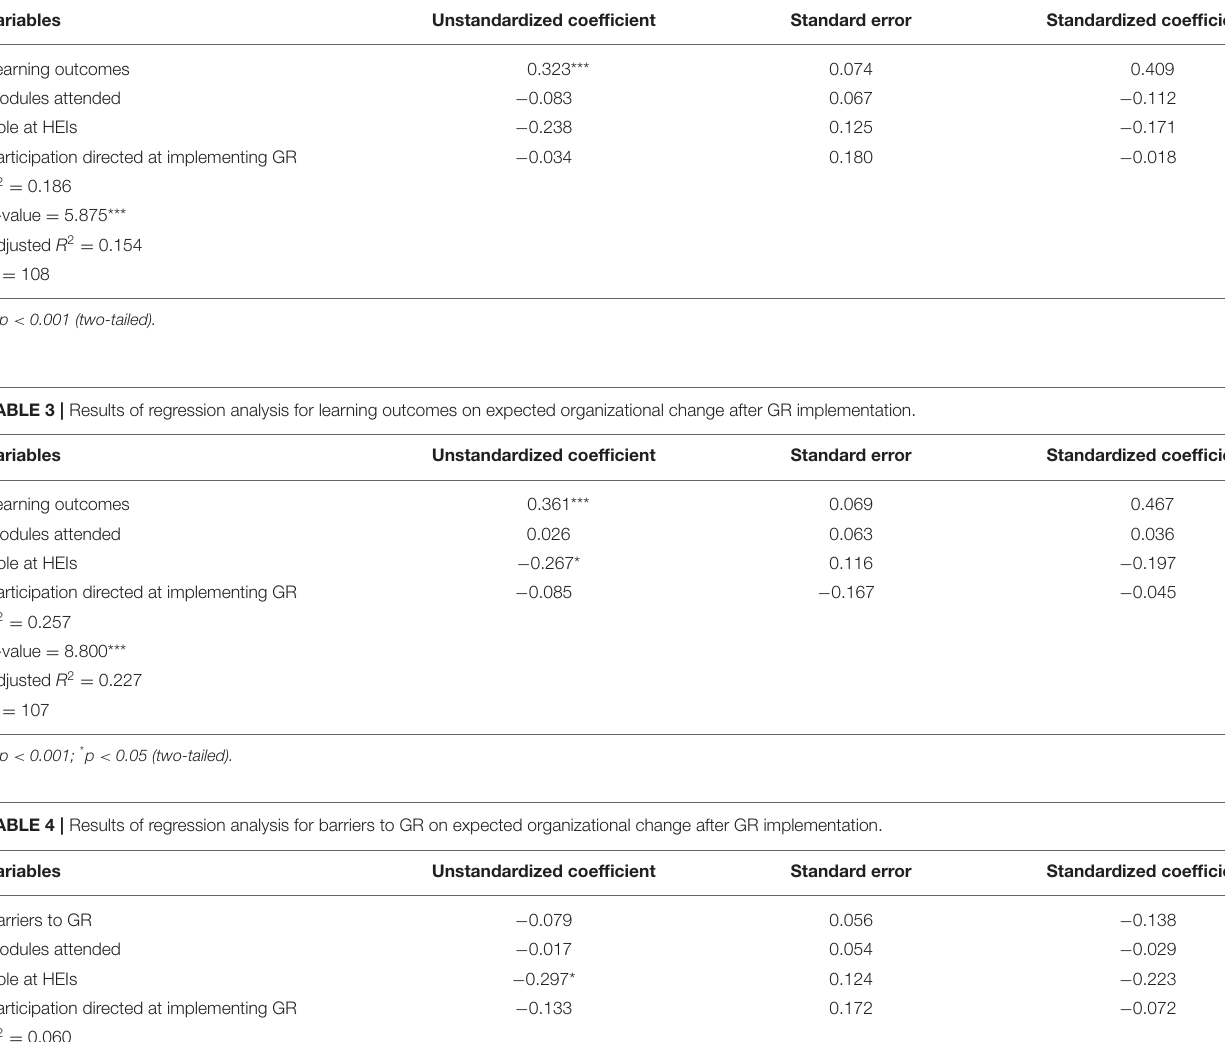
TABLE 2 | Results of regression analysis for learning outcomes on expected achievement of GR objectives after GR implementation.